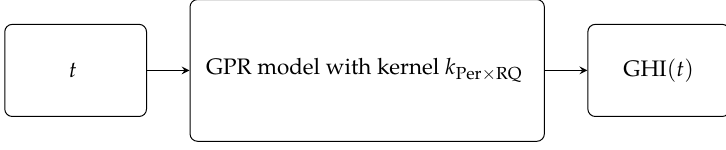
Figure 2. Time-based GPR model with kernel k Per